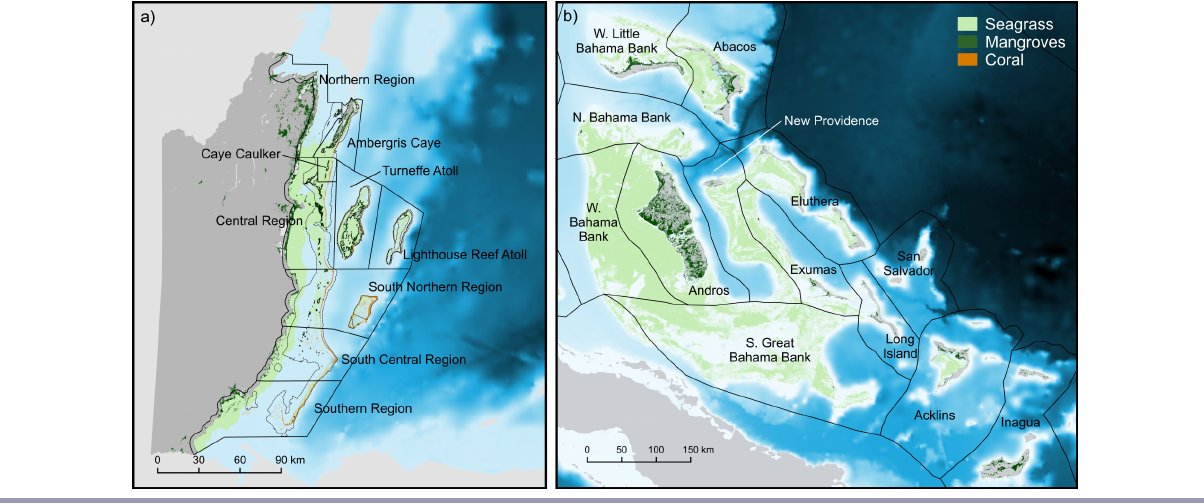
Fig. 1 . Lobster habitat in each of nine planning regions in Belize (a) and by ecoregion in The Bahamas (b). Blue indicates depth